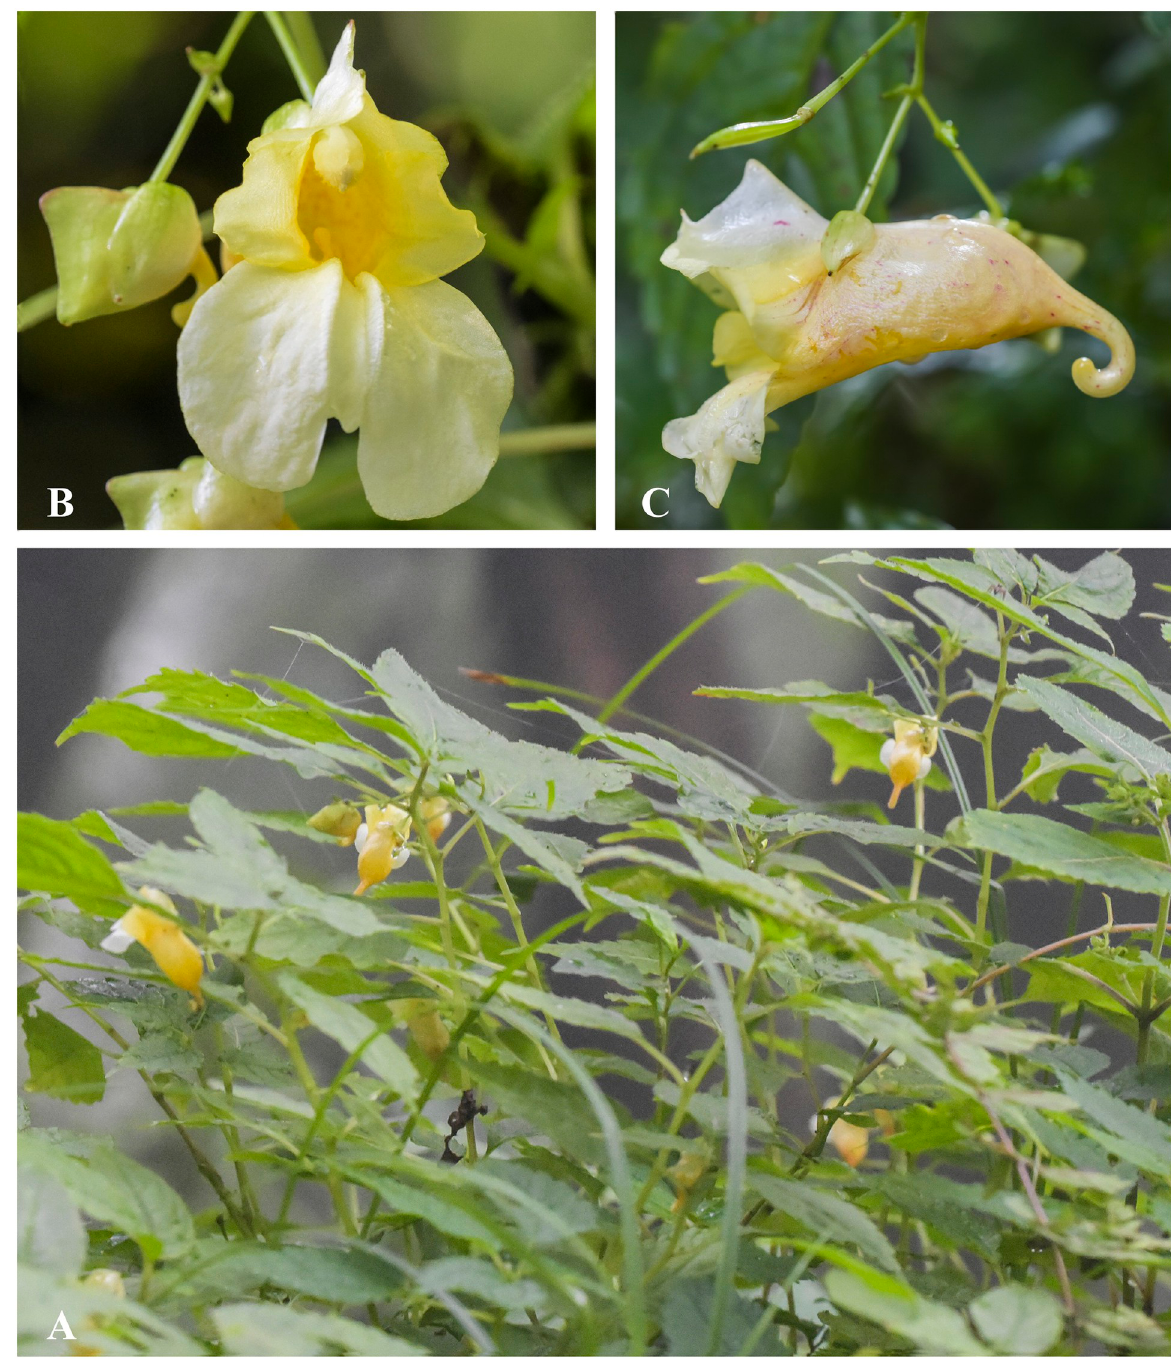
Fig 10. Impatiens discolor A. Flowering plant; B. Flower (front view); C. Flower (side view). Photographs by Bhakta Bahadur Raskoti.